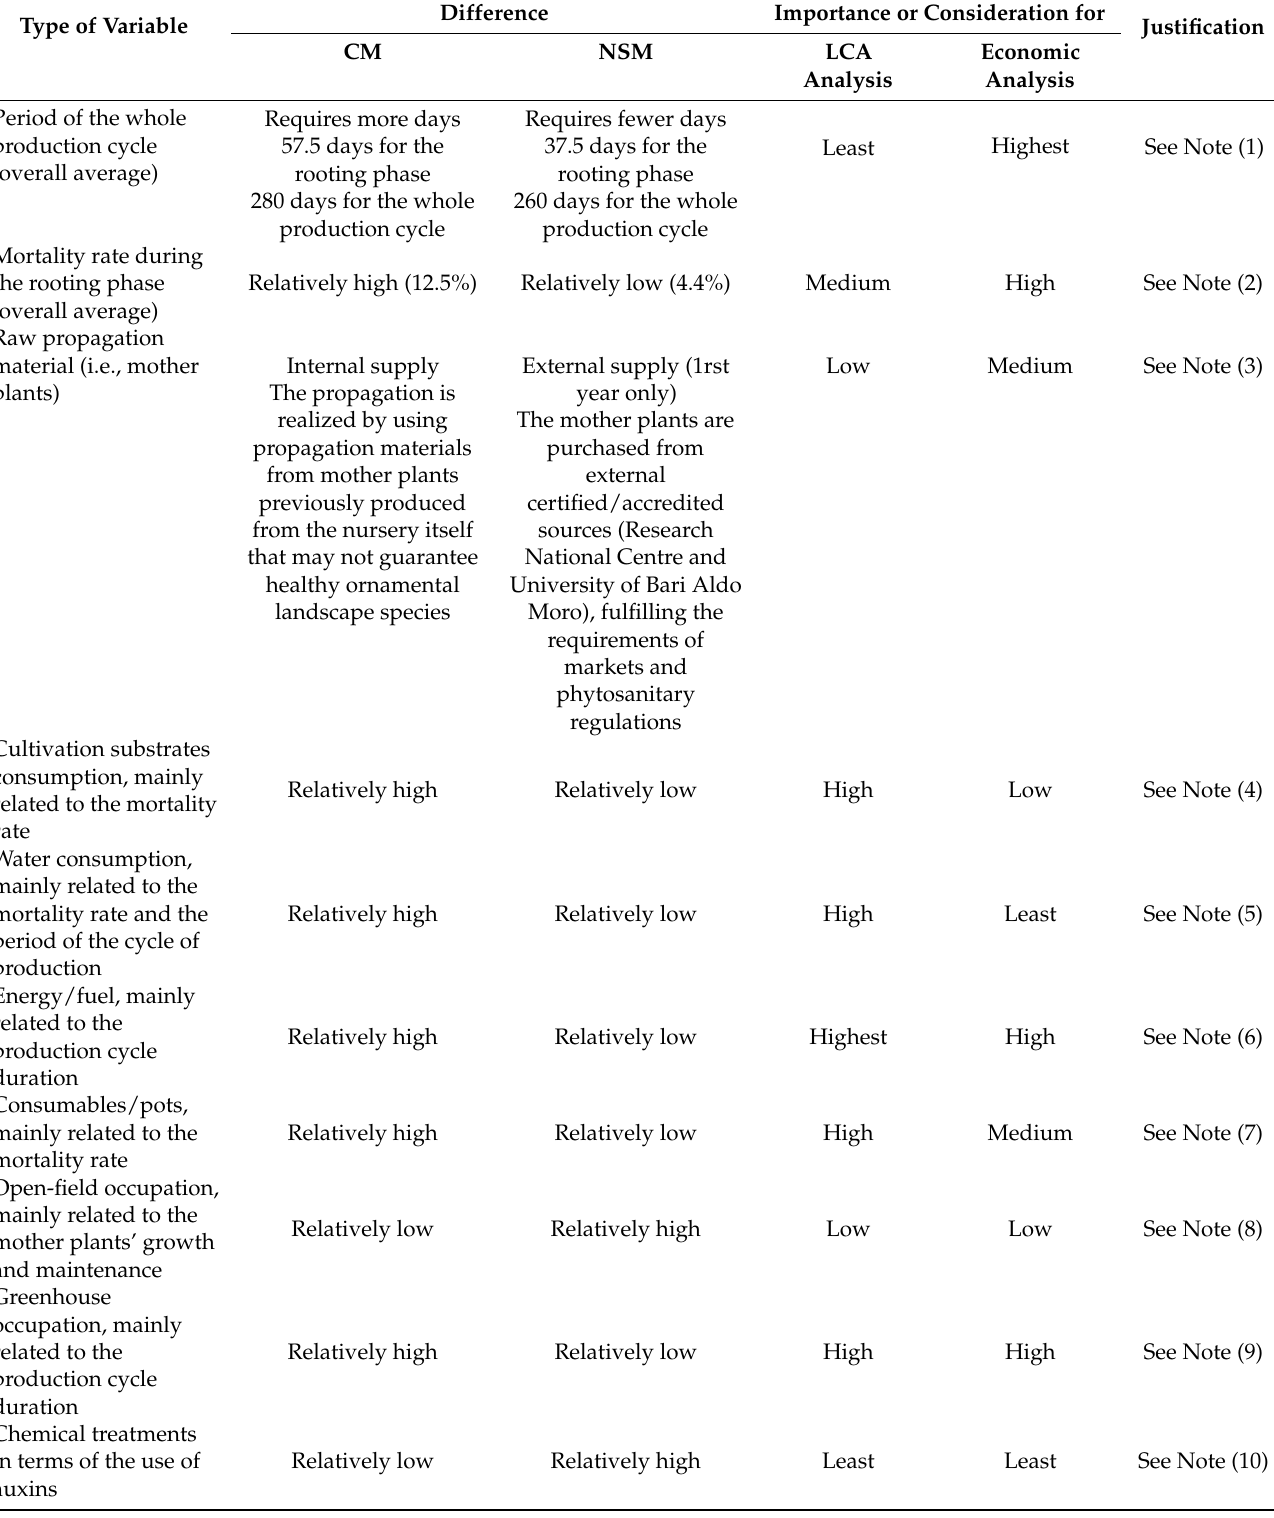
Table 4. Differences between the two production models: conventional production model (CM) and novel and sustainable production model (NSM), among eight selected ornamental